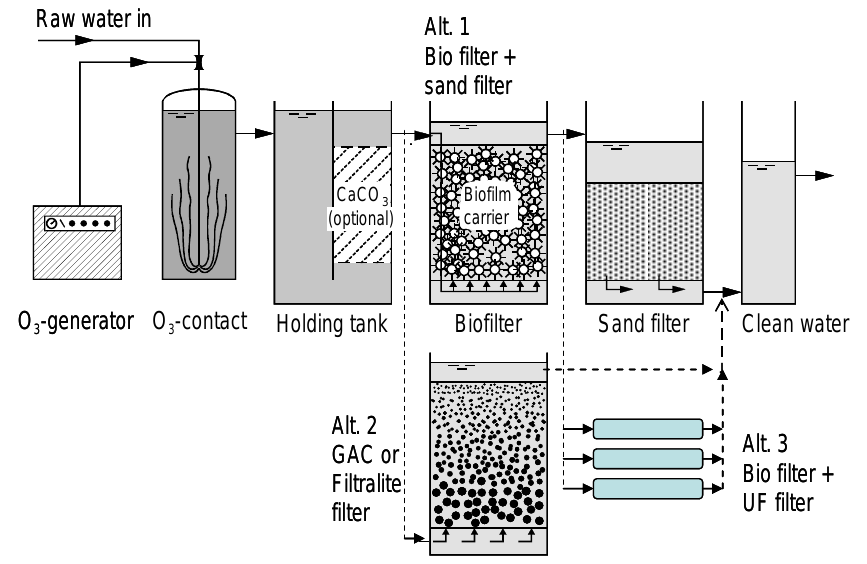
Fig. 7 Color reduction versus specific ozon dose